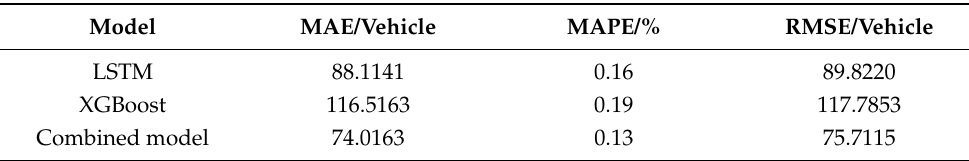
Table 1. A comparison of MAE, MAPE and RMSE for different models.